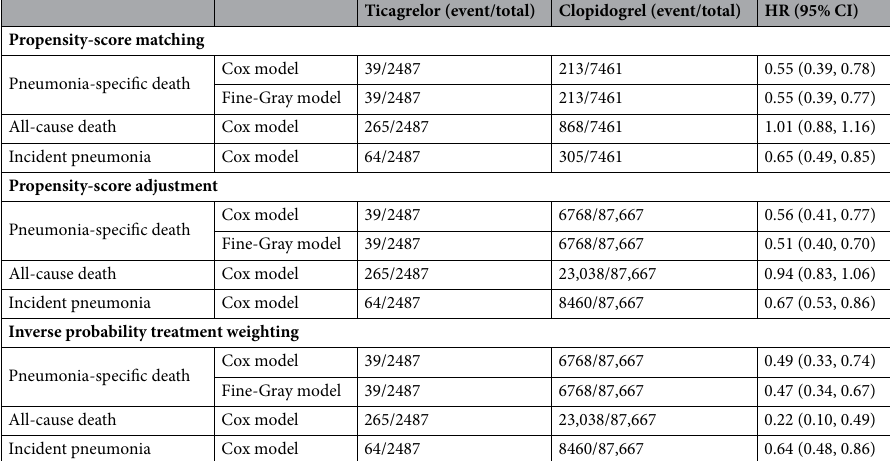
Table 3. The association between use of ticagrelor with pneumonia-specific death, all-cause death, and incident pneumonia, using propensity-score matching, adjustment and weighting methods. Adjusted for age, gender, Charlson Comorbidity Index, number of outpatient visits during previous 12 months, number of hospitalizations during previous 12 months, year of first drug dispensing date, duration of drug use, baseline cerebrovascular diseases, diabetes and chronic obstructive pulmonary disease. Fine-Gray model is a survival model taking into account competing